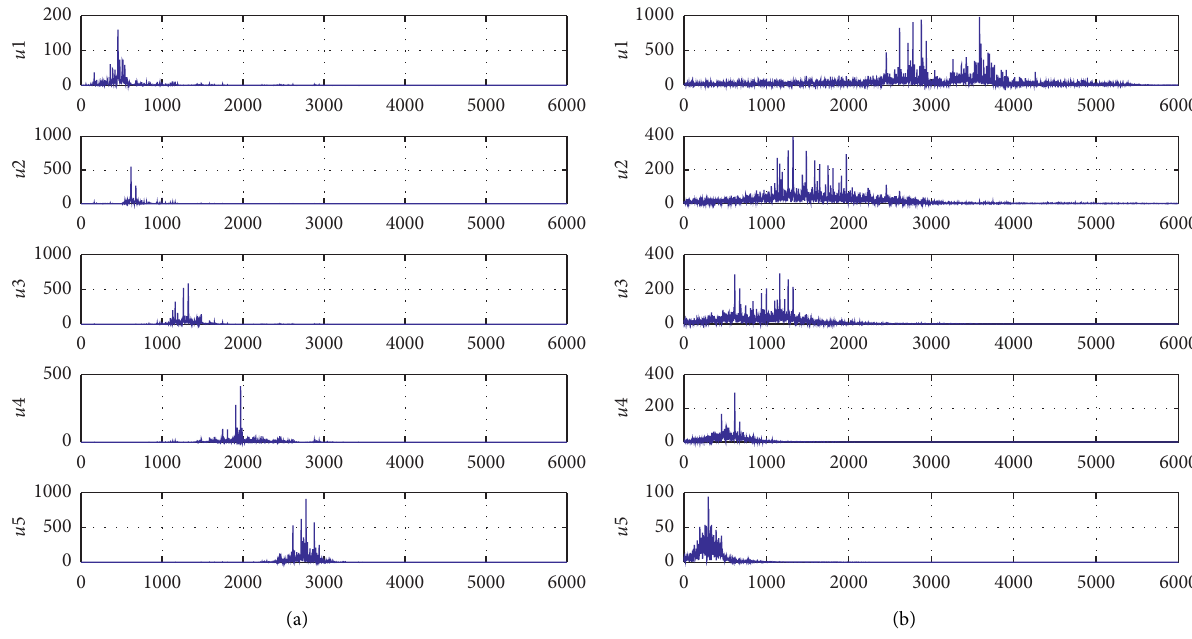
Figure 16: Frequency spectrums of u 1, u 2, u 3, u 4, and u 5 decomposed by (a) GWOMI-VMD and (b)